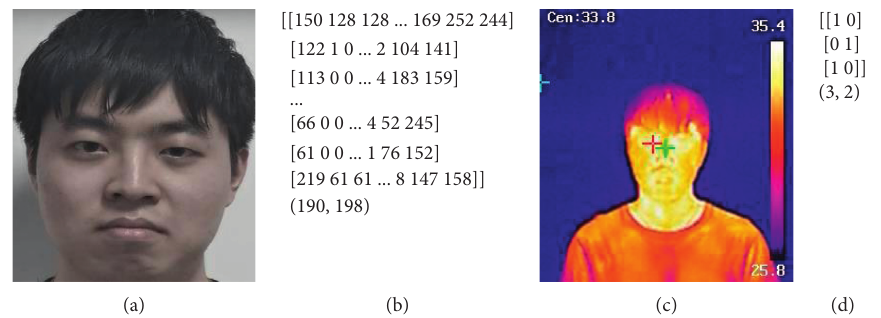
Figure 7: Feature vectors (b, d) obtained from the text data contained in images (a) and (c) after CNN+LSTM neural network.